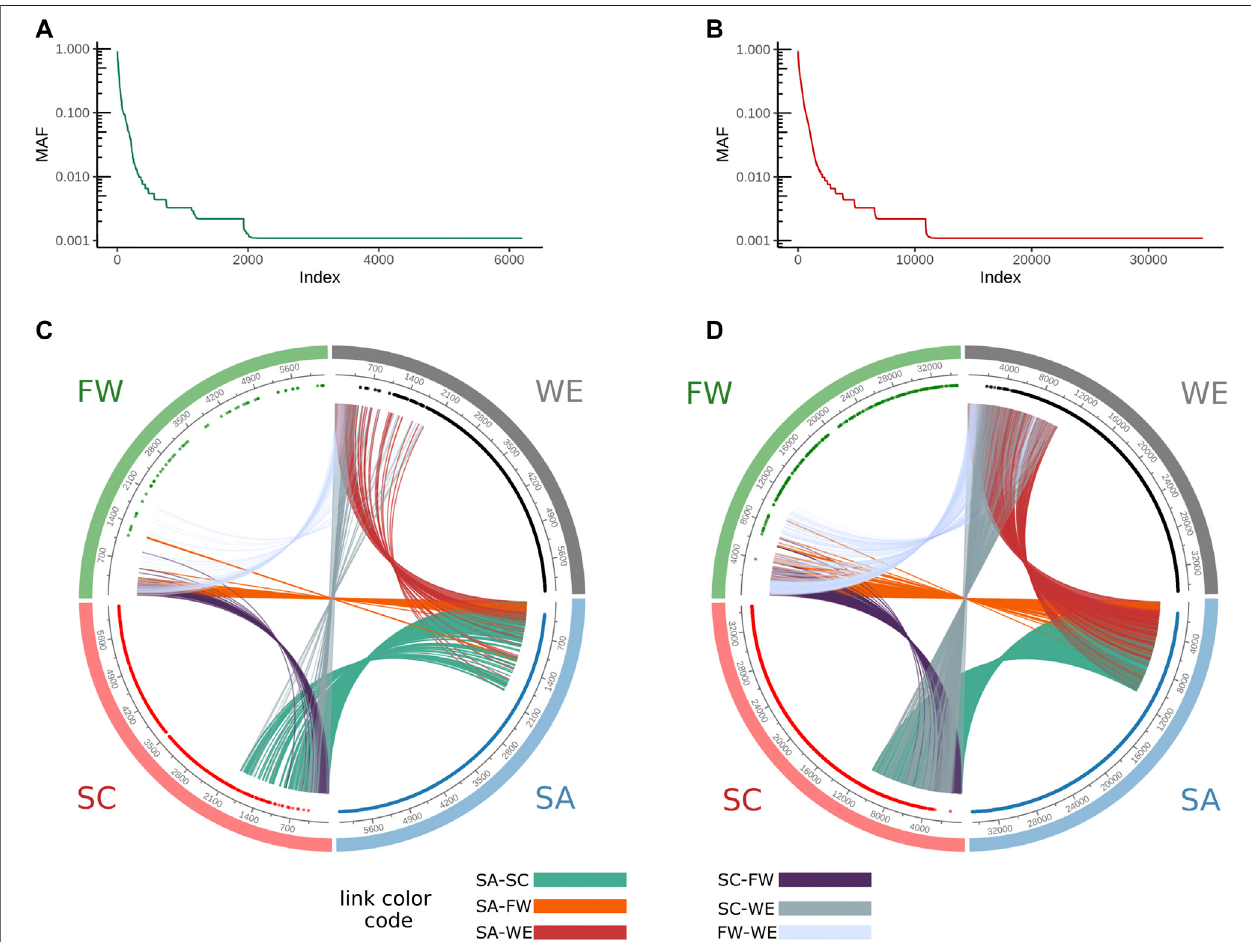
FIGURE 8 | The number of novel high impact variants in ADME protein families. Abbreviation for Protein families: AD, aldehyde dehydrogenase; ANA, arylamine N-acetyltransferase; ATPDABZ, ATP-dependent AMP-binding enzyme; CATA, cation transport ATPase; CYP450, cytochrome P450; DADA, DAMOX/DASOX; DASS, SLC13A/DASStransporter;EPH,epoxidehydrolase;GPER,glutathioneperoxidase;GSTA,GSTalpha;GSTM,GSTMu;ICAD,iron-containingalcoholdehydrogenase; LAAT,L-typeaminoacidtransporter;NCYP450,NADPH – cytochromeP450reductase;NHRF,nuclearhormonereceptorfamily;OCTF,organiccationtransporter family; PEROX, peroxidase; SDR, short-chain dehydrogenases/reductases; ST2, sulfotransferase 2; SUGT, Sugar transporter; SULF1, sulfotransferase 1; UDPGT, UDP-glycosyltransferase. ABCC, ABCB, ABCA, FMO, ABCG are not abbreviated. On the structures, we showed examples of variants for four proteins belonging to different protein families described in Section 2.6